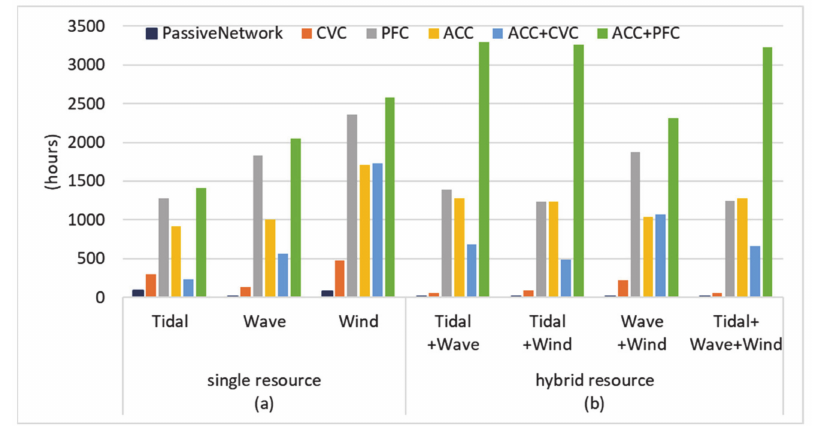
Figure 6. Total hours in the year when at least one bus voltage reaches its upper limits: ( a ) for single resource networks and ( b ) for hybrid resource networks.